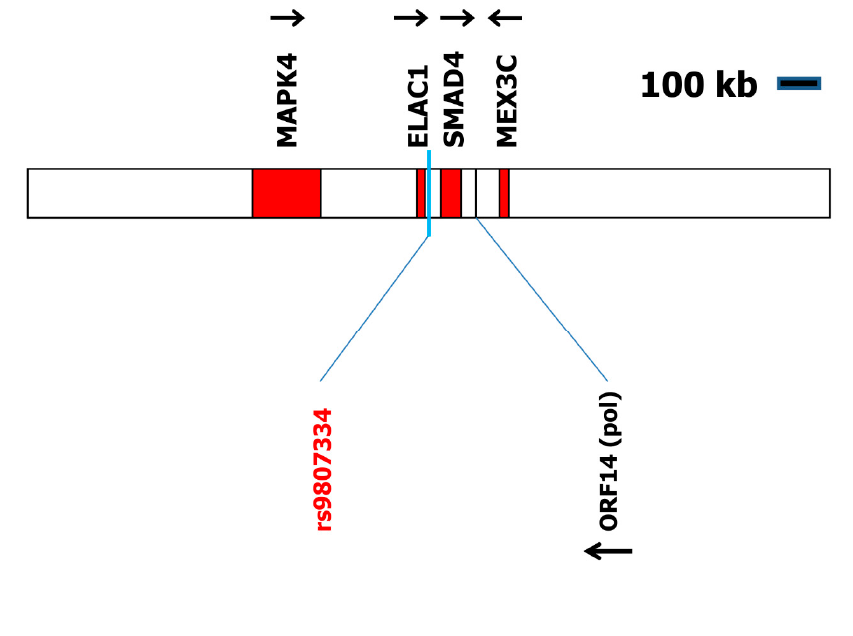
Figure 1. Schematic organization of the locus on human chromosome 18 including rs9807334. The two megabase pairs flanking rs9807334 were analyzed using getorf for the presence of open reading frames (ORFs) with a minimal length of one kilobase. Sixteen ORFs were identified (see Supplementary Table S1). These ORFs were analyzed using BLASTP against the database of retro-transcribing viruses (taxid:35268). One ORF with high sequence similarity to retroviruses was identified. This ORF is located between the SMAD family member 4 (SMAD4) locus and the Mex-3 homolog C (MEX3C) locus (for a complete list of all genes in this chromosomal region see Supplementary Table S2. ELAC1: elaC-like short form of RNase Z; MAPK4: mitogen-activated protein kinase 4; MEX3C: mex-3 RNA binding family member C; SMAD4: small body size and mothers against decapentaplegic homolog 4. Arrows indicate the direction of the ORFs.